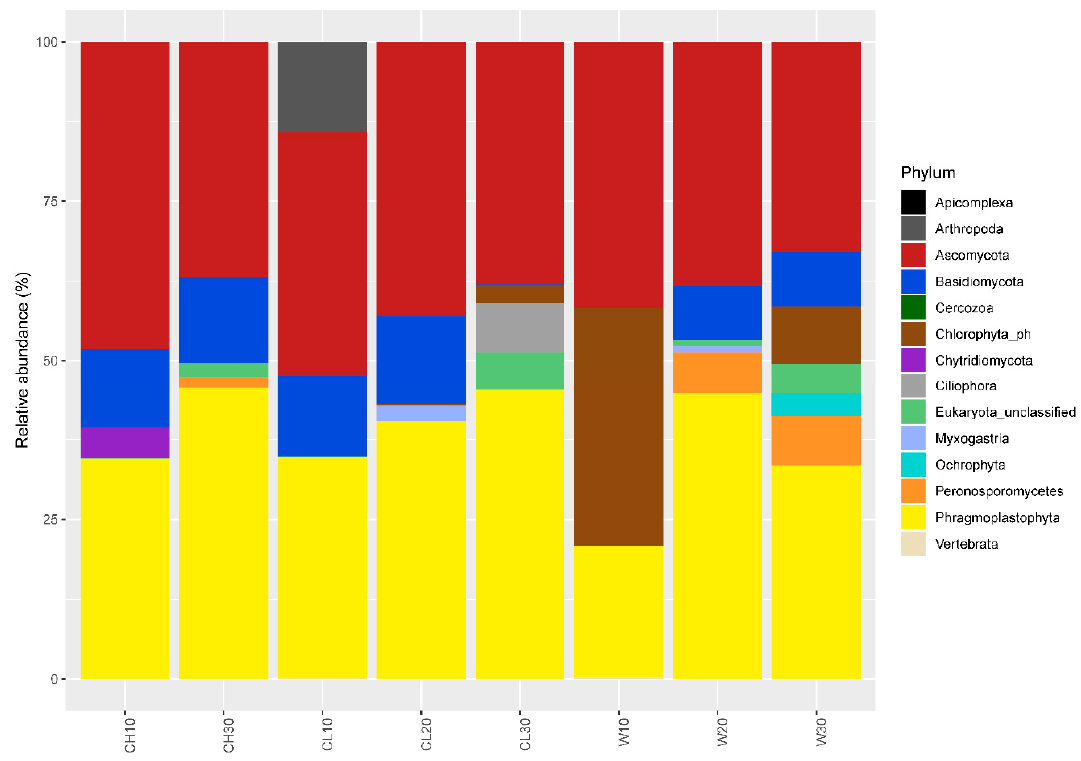
Figure 5. Eukaryotic phylum composition of the samples. Each of CH10, CH30 indicates samples collected in Chilbolton at high elevation (range of 950 – 1000 m asl) in the time duration of 10 min and 30 min. Each of CL10, CL20, CL30, indicates samples collected in Chilbolton at low elevation (range of 300 – 450 m asl) in the time duration of 10, 20, and 30 min. W10, W20, W30, indicates the different samples collected in Weybourne (height range of 650 – 1000 m) with time durations of 10, 20, and 30 min respectively.